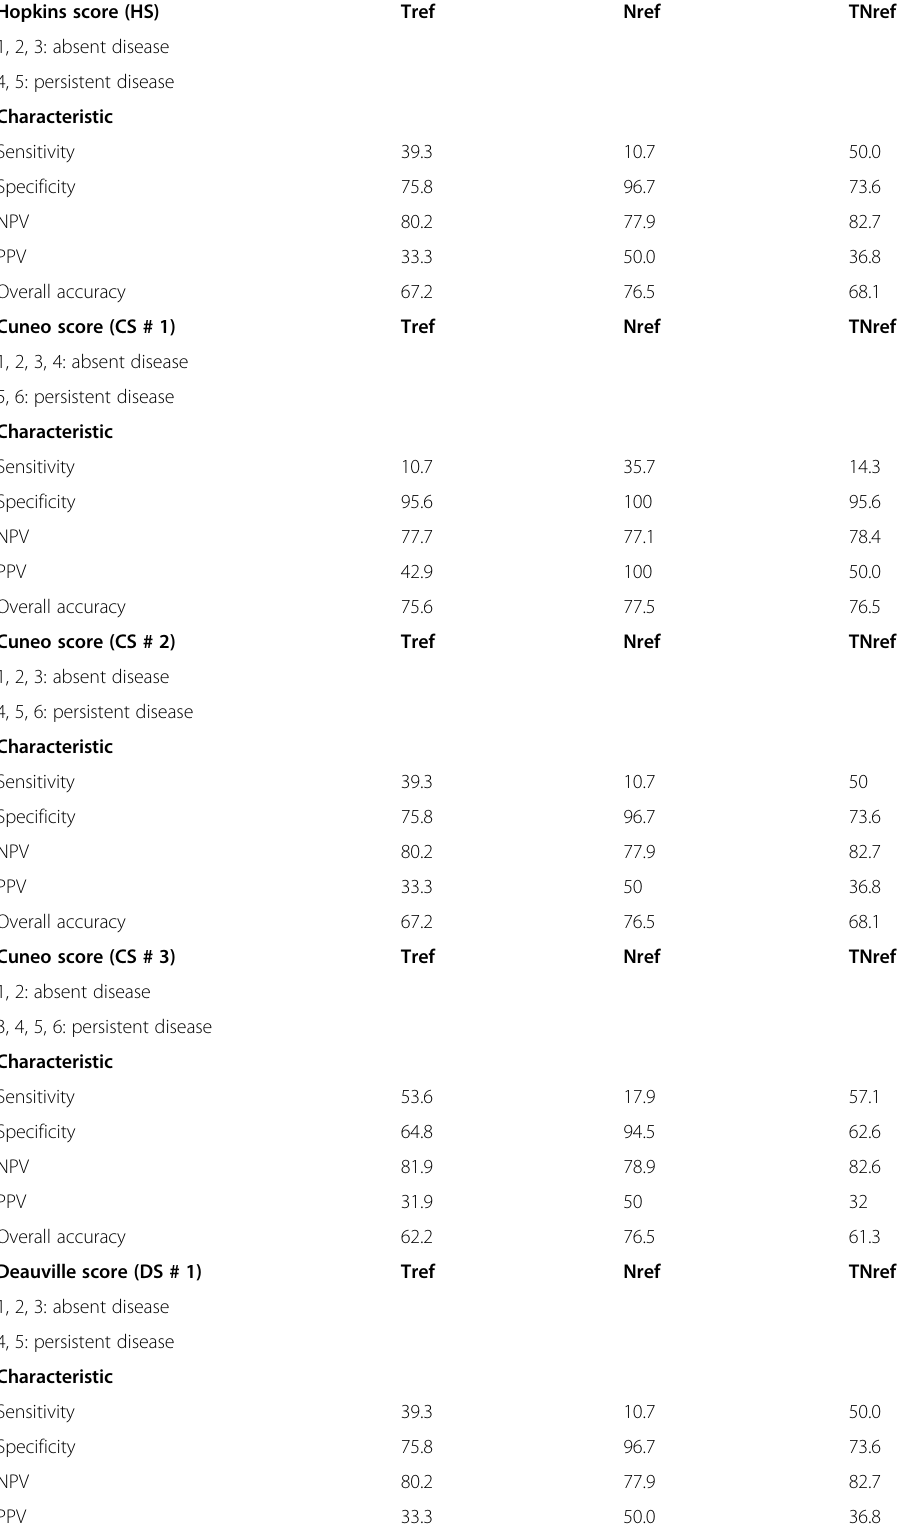
Table 4 Overall diagnostic accuracy using standardized reporting criteria (Deauville, Hopkins, and Cuneo scores) Hopkins score (HS) Tref Nref